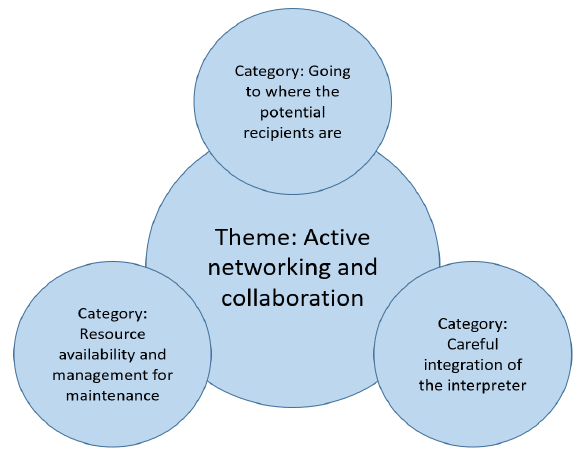
Figure 2. Overview of results.